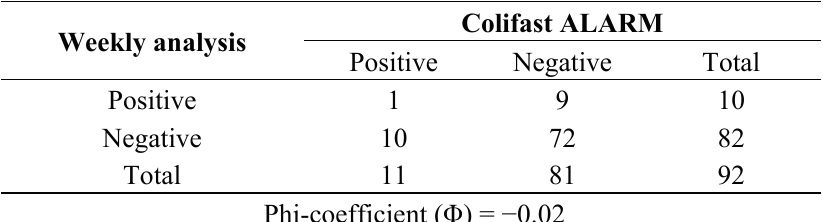
Table 1. Statistical comparison of the detection of Escherichia coli in raw water at Oset water treatment plant by the weekly routine method and Colifast ALARM based on the total of 92 sample-days where weekly samples and ALARM samples were taken within a time difference of less than 8